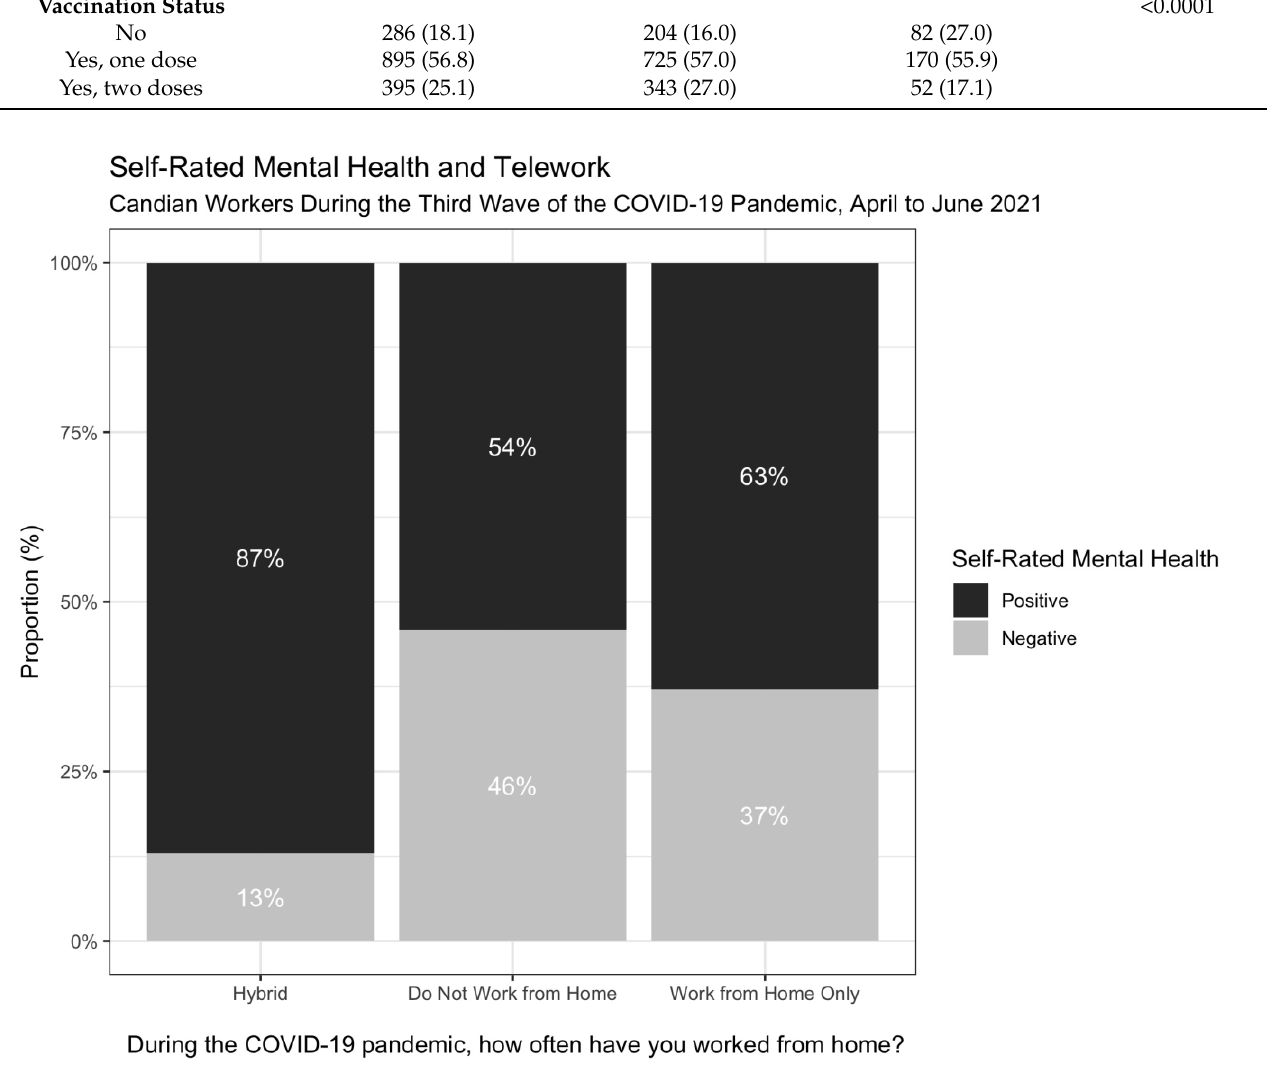
Figure 1. Work Setting and Self-Rated Mental Health. Table 1. Sample Characteristics Stratified by Self-Rated Mental Health.